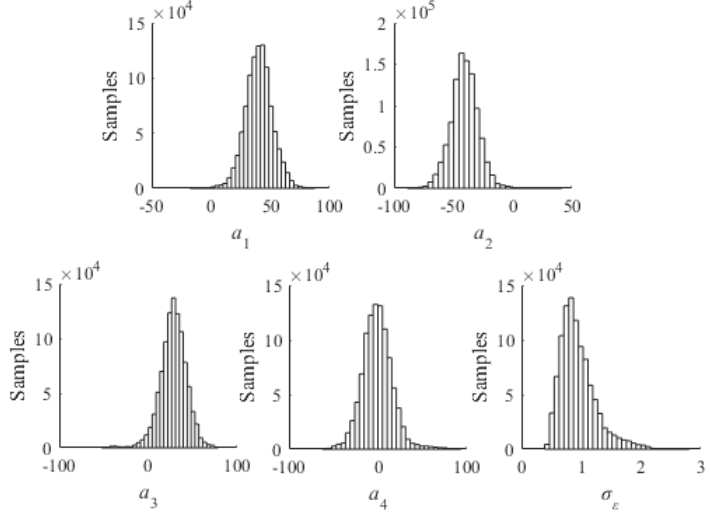
Figure 7. Histograms of prior model parameters estimated using FE simulation data.